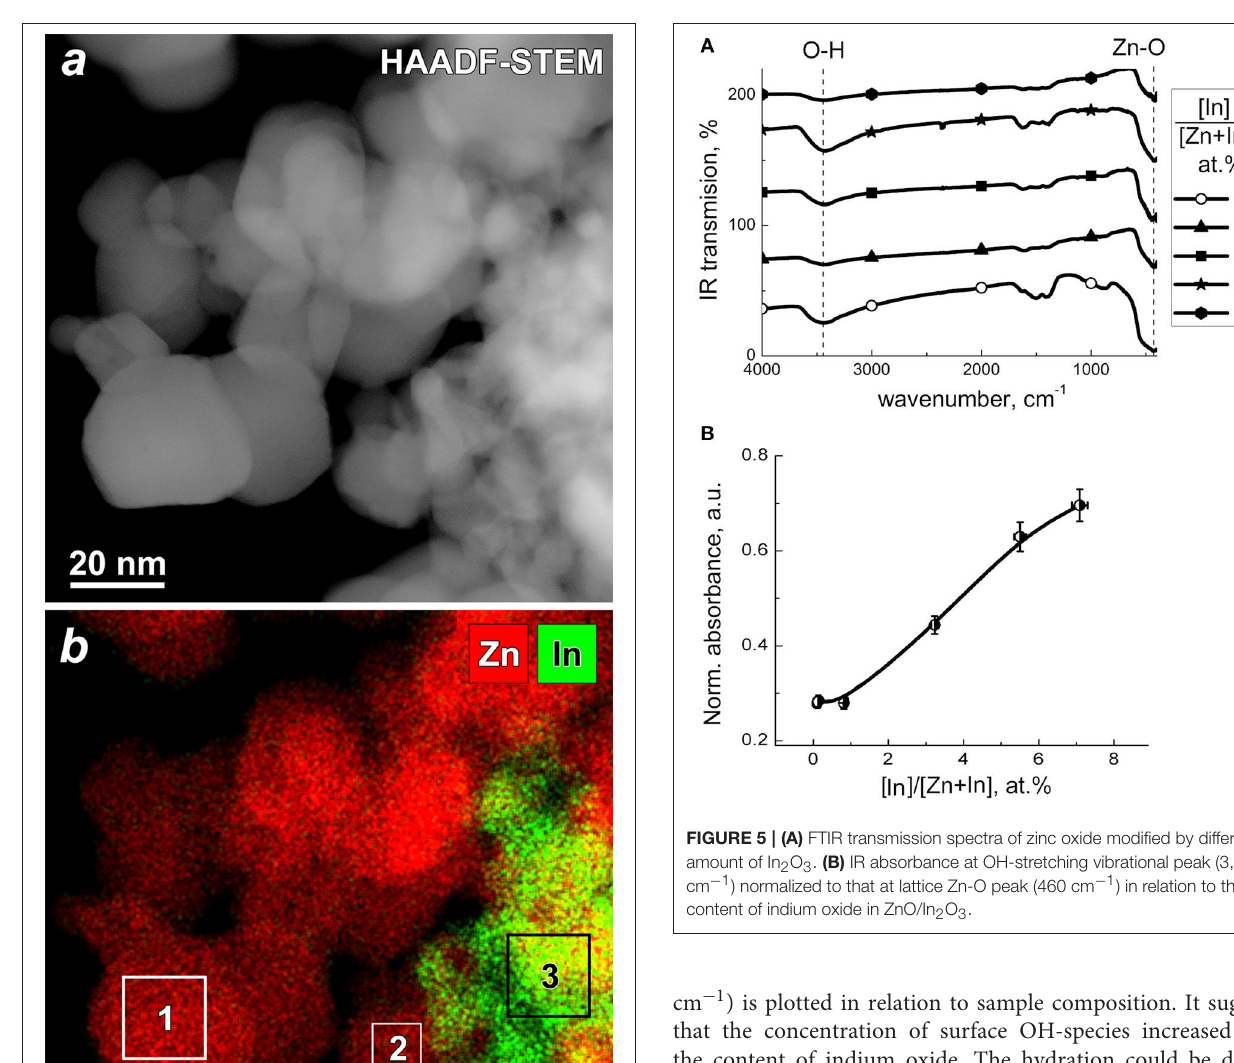
cm − 1 ) is plotted in relation to sample composition. It suggests that the concentration of surface OH-species increased with the content of indium oxide. The hydration could be due to an increasing number of In(III)-ions segregated on the surface, which is in agreement with the higher OH adsorption